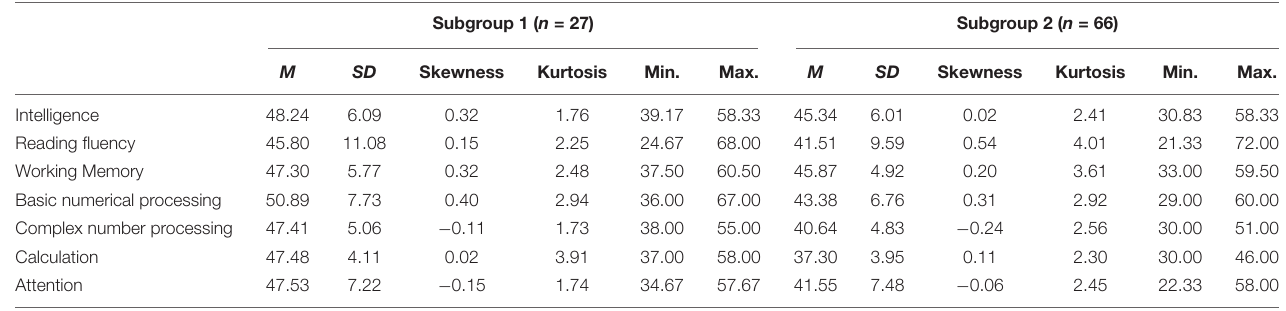
TABLE 1 | Descriptive statistics of the ZAREKI-R sample—clustered by constructs.